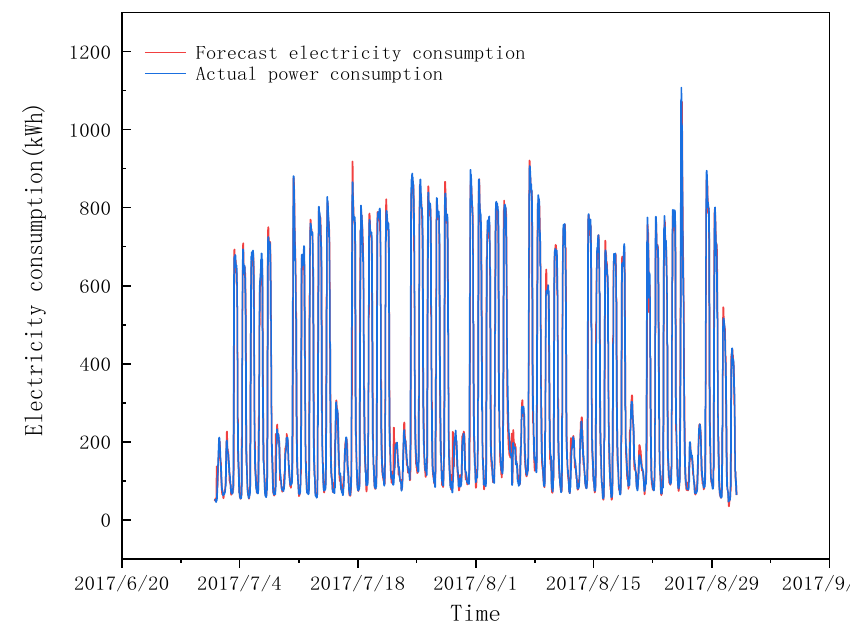
concentrated around 7:00 and 8:00 on weekdays, in summer or winter.